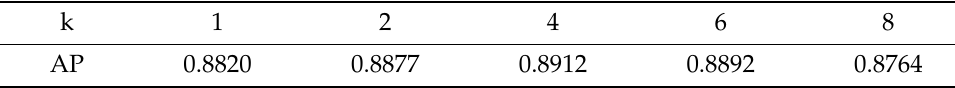
Table 3. The influence of the ellipse parameter